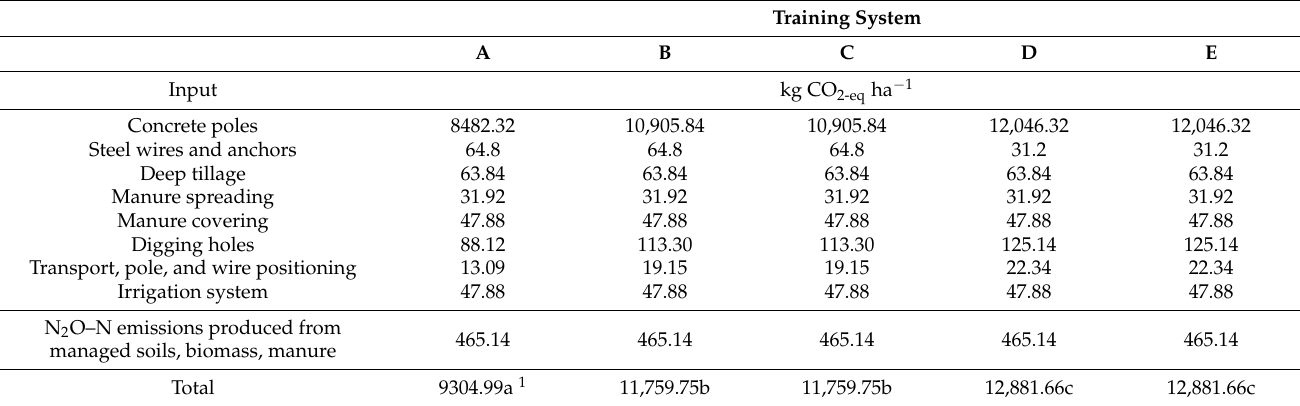
Table 6. Total GHG emissions associated with vineyard planting (kg CO 2-eq ha − 1 ).